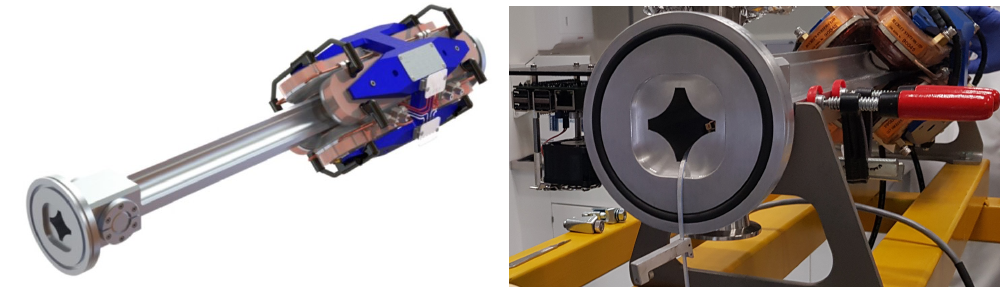
Figure 1. The compact 40 cm long magnet of the Mini-PET BeamLine (MBL) ( left ) and the peculiar transverse shape of the beam pipe ( right